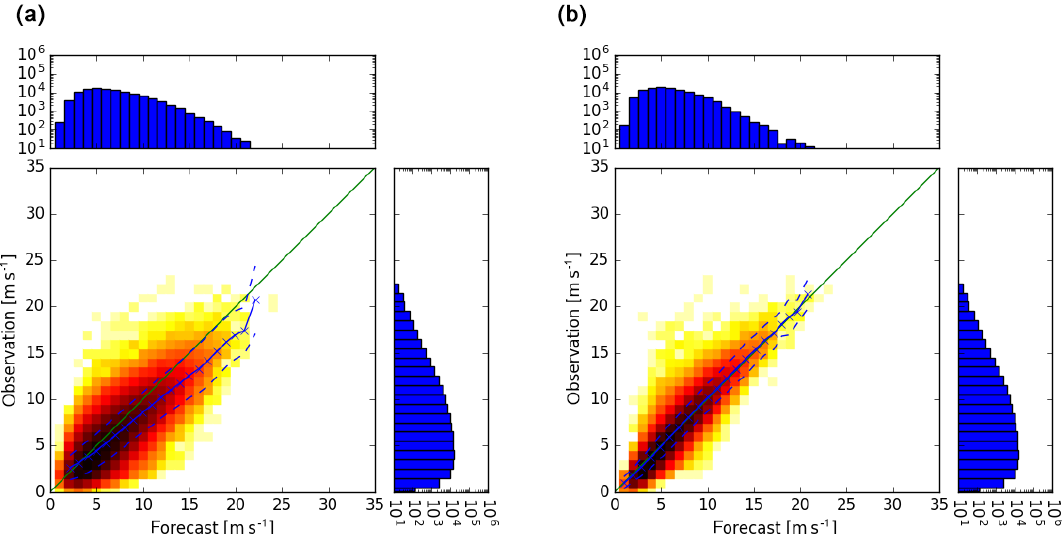
Figure 8. As Fig. 6 but for 3 months of data (May–July 2016) and forecasts of COSMO-DE-EPS (a) and Ensemble-MOS (b) . Data of this period were not used for training.